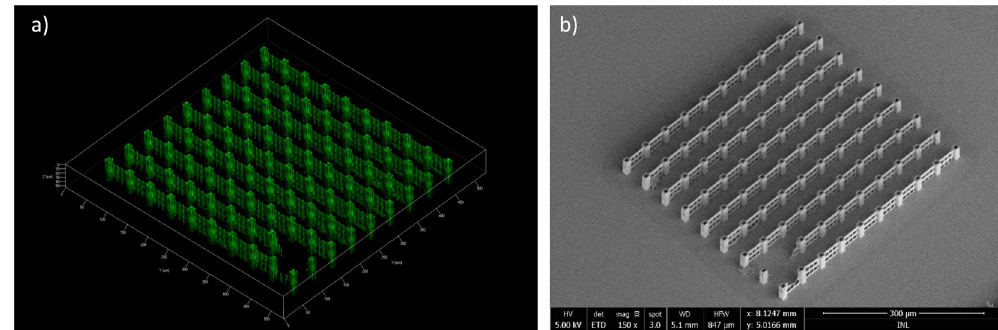
Figure 5. Array of supported stitched parallel fabricated unit structures. ( a ) Confocal fluorescence image of the full structure. ( b ) SEM micrograph of the full structure covering an area of 450 × 450 µ m 2 and with added thin 10 nm gold layer. Fabrication time is 56 min for the full array where each individual unit structure takes 373 s.